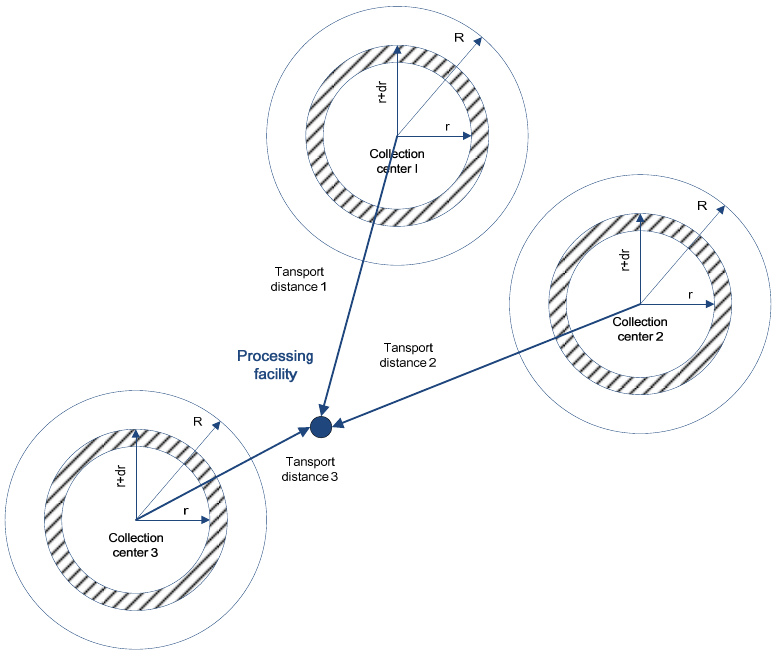
Figure 3. Feedstock transport